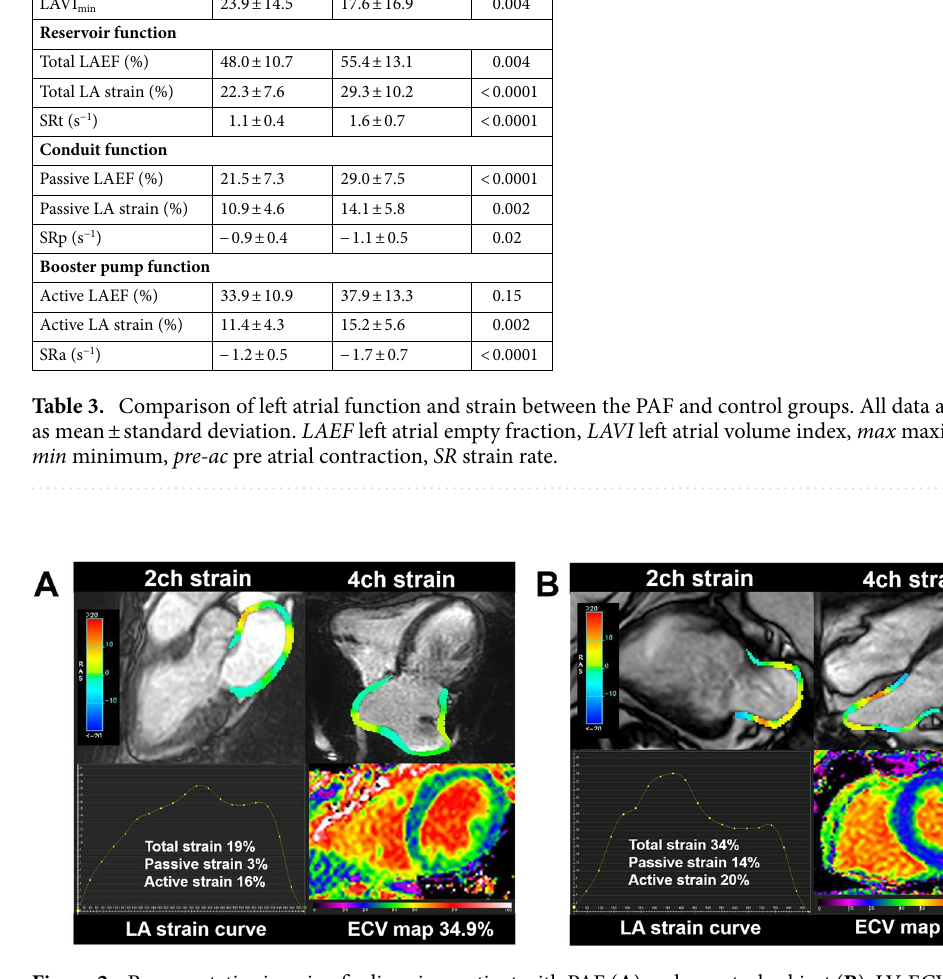
Figure 2. Representative imaging findings in a patient with PAF ( A ) and a control subject ( B ). LV-ECV is higher in the patient with PAF (34.9%) than in the control subject (26.9%), indicating advanced myocardial fibrosis. LA strain analysis reveals that total and passive strain is substantially lower in PAF (total strain: 19% vs. 34%, passive strain: 3% vs. 14%), while active strain is similar between the patient with PAF and the control subject (16% vs.